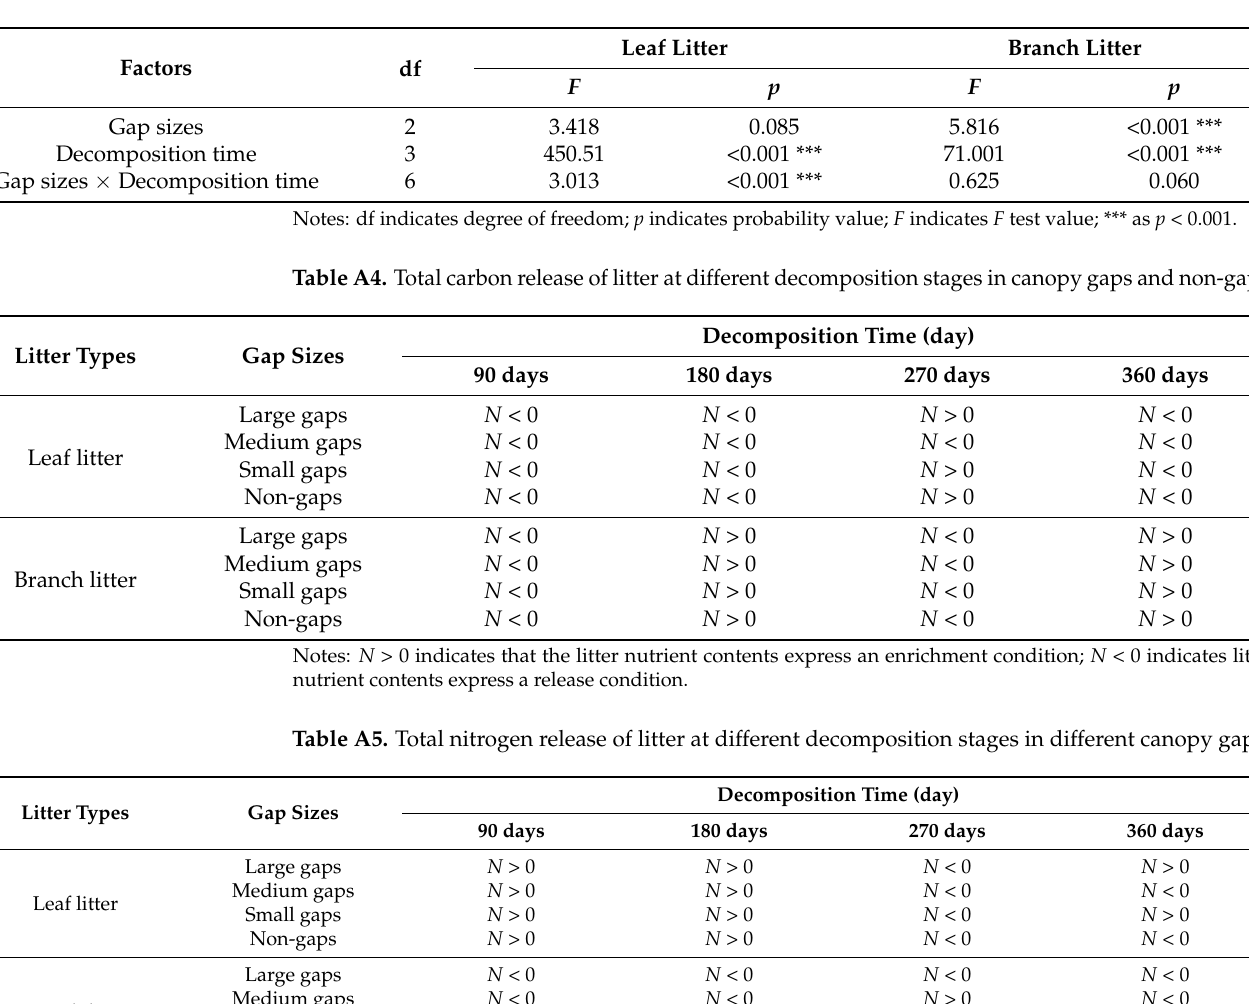
Table A3. Two-way ANOVA results for the effects of gap size and time on mass changes of leaf and branch litter.